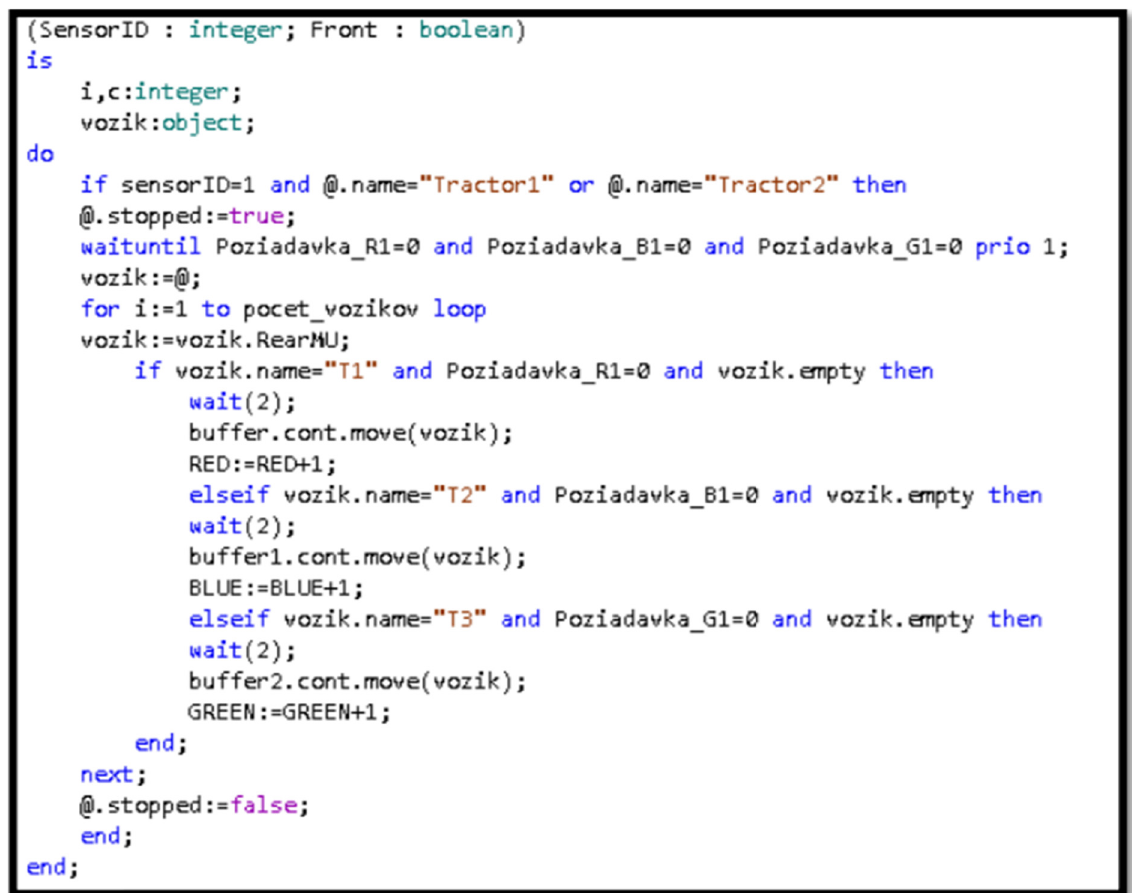
Figure 8: Created program sequence of the logistics train for